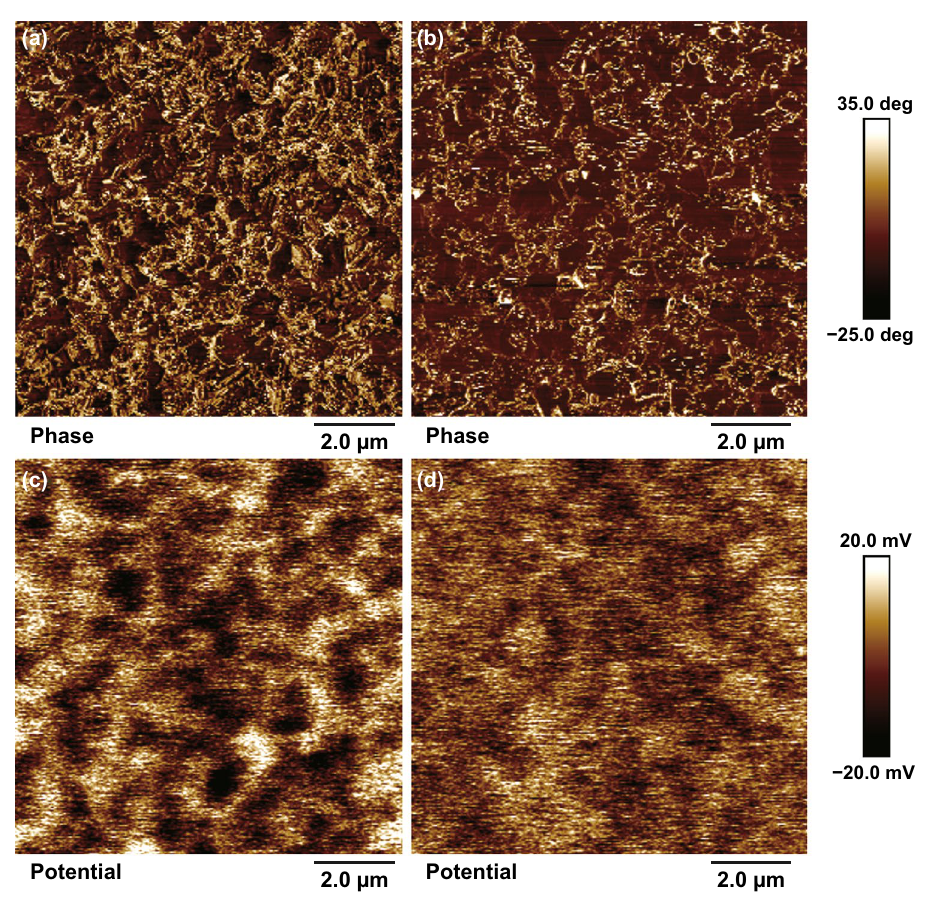
Fig. 5 a, b AFM phase images and c, d 2D surface potential spatial maps of a, c the control perovskite film and b, d the perovskite film pre‑ pared through LTAG at 30